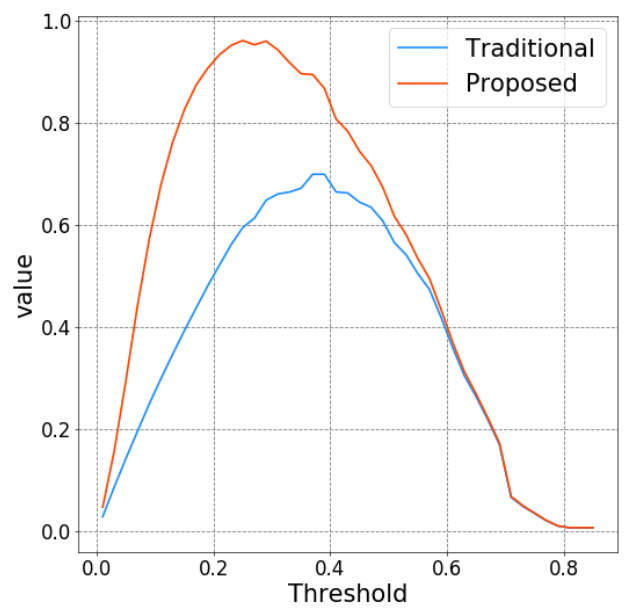
Figure 6. The connectivity efficiency of the proposed method and the traditional method. The connectivity efficiency, the strength of the edge connection nodes, is defined as Equation (6). The connection efficiency is a convex function with respect to the threshold. The connection efficiency increases first as the threshold increases and then decreases after the maximum value is